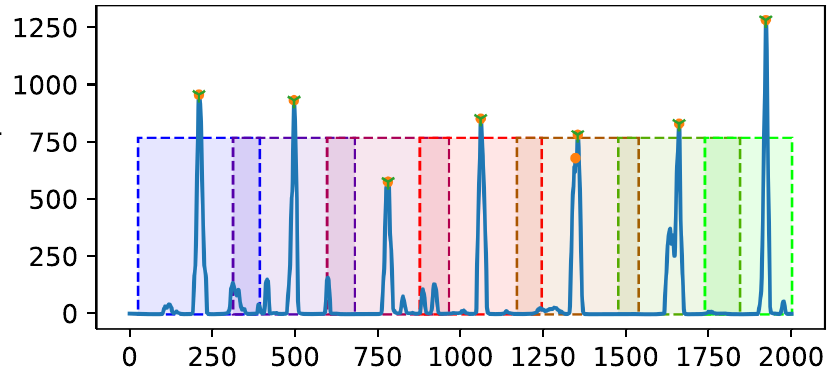
Figure 5. Selection of peaks in the horizontal profile for one example image (length of 2000 pixels) with 7 chain lines from the validation set. The peaks are marked with an orange dot, and the final selection of peaks after distance thresholding are additionally marked with a green cross. Then, a bounding box is placed at the center of each selected